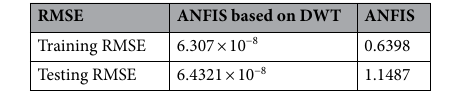
Table 6. The performance evaluation of ANFIS.